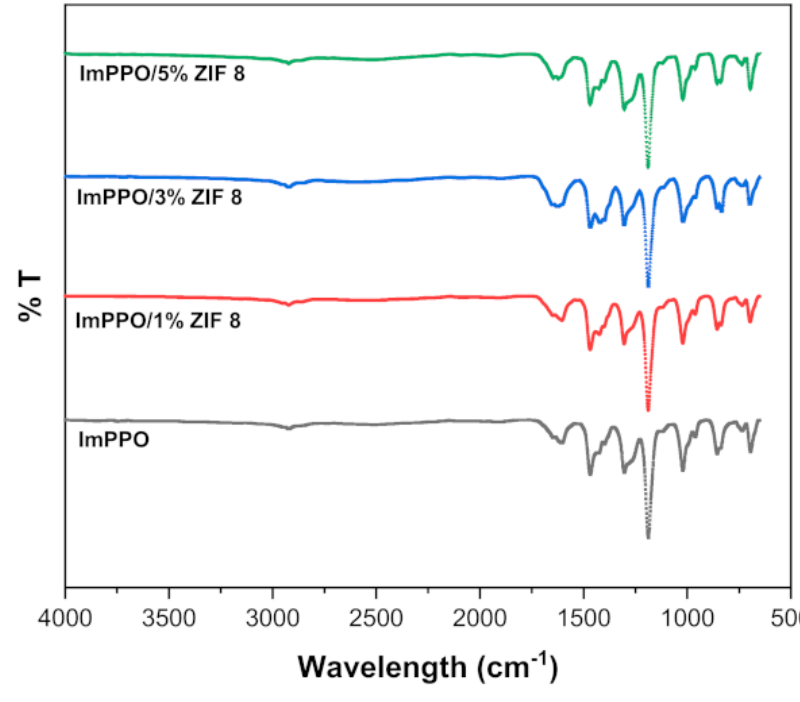
Figure 6. FTIR spectra of ImPPO/ZIF-8 composite membranes.